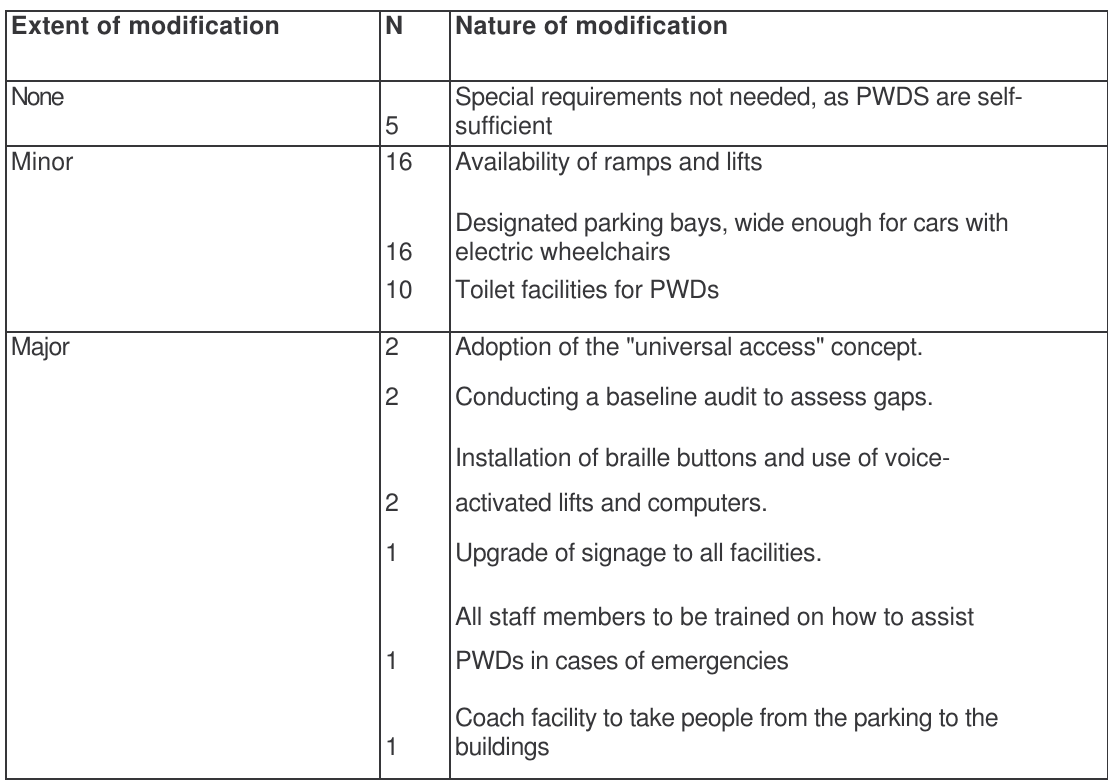
Table 8: Accessibility of facilities Extent of modification